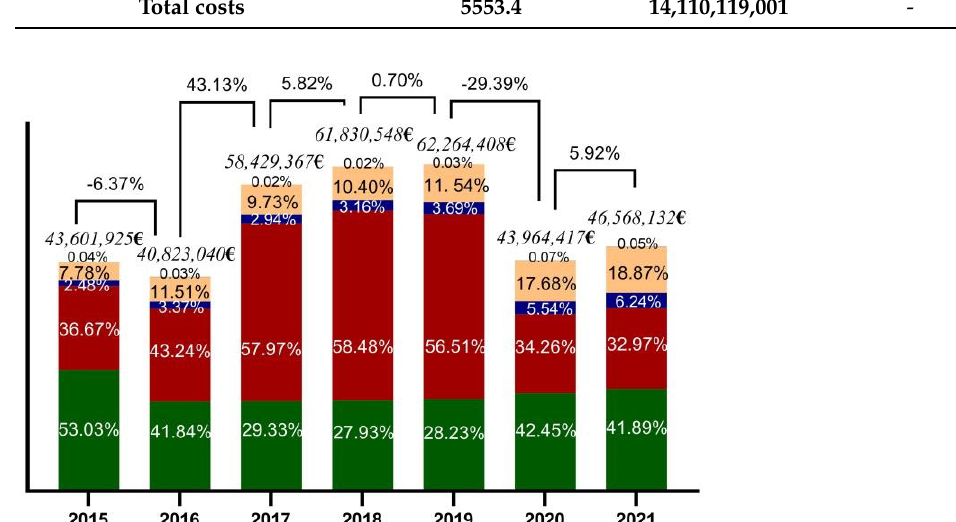
Figure 2. Direct costs in the treatment of depression, compared by year, for primary care (black), specialized services (orange), psychotherapy (dark blue), hospitalization (red), and medication (green).